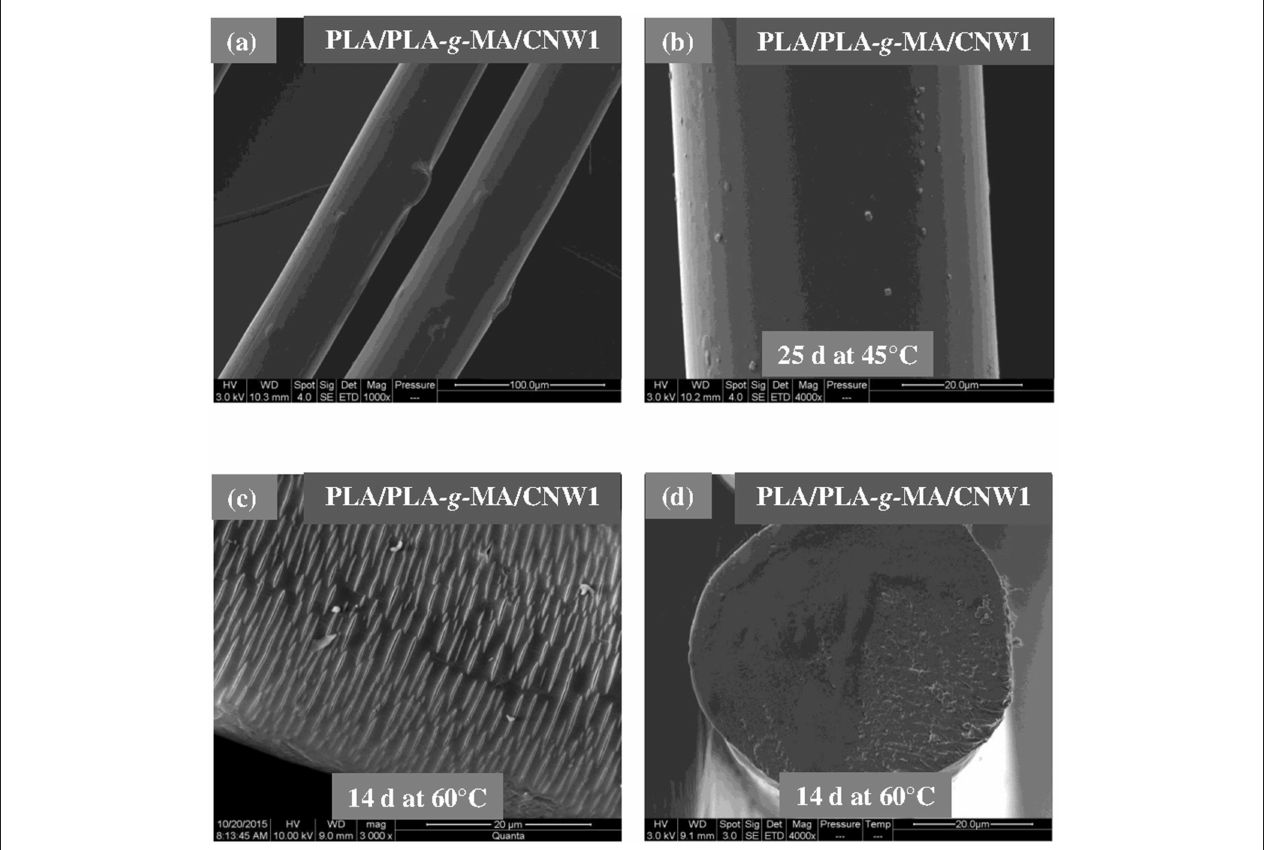
FIGURE 5 | SEM micrographs of external surface of a PLA/PLA -g- MA/CNW1 fiber. (a) Before exposure, (b) after 25 days at 45 ◦ C, (c) after 14 days at 60 ◦ C, and (d) SEM micrograph of cross-sectional surface of a PLA fiber after 14 days at 60 ◦ C.